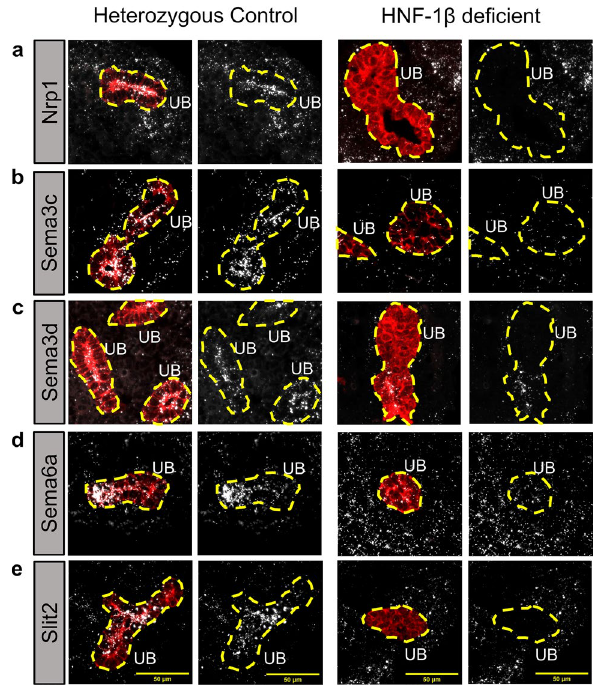
Figure 5. Dysregulation of axon guidance genes in HNF-1β mutant kidneys. Dual RNAscope-indirect immunofluorescence was performed on sagittal sections of E14.5 heterozygous control and HNF-1β mutant kidneys. Sections were stained using an anti-RFP (TdTomato) antibody (red) to visualize ureteric buds (UB). RNAscope in situ hybridization signals are shown in white. UBs are outlined in yellow dashed lines. RNAscope channels are shown alone for clarity on the right. Scale bar indicates 50